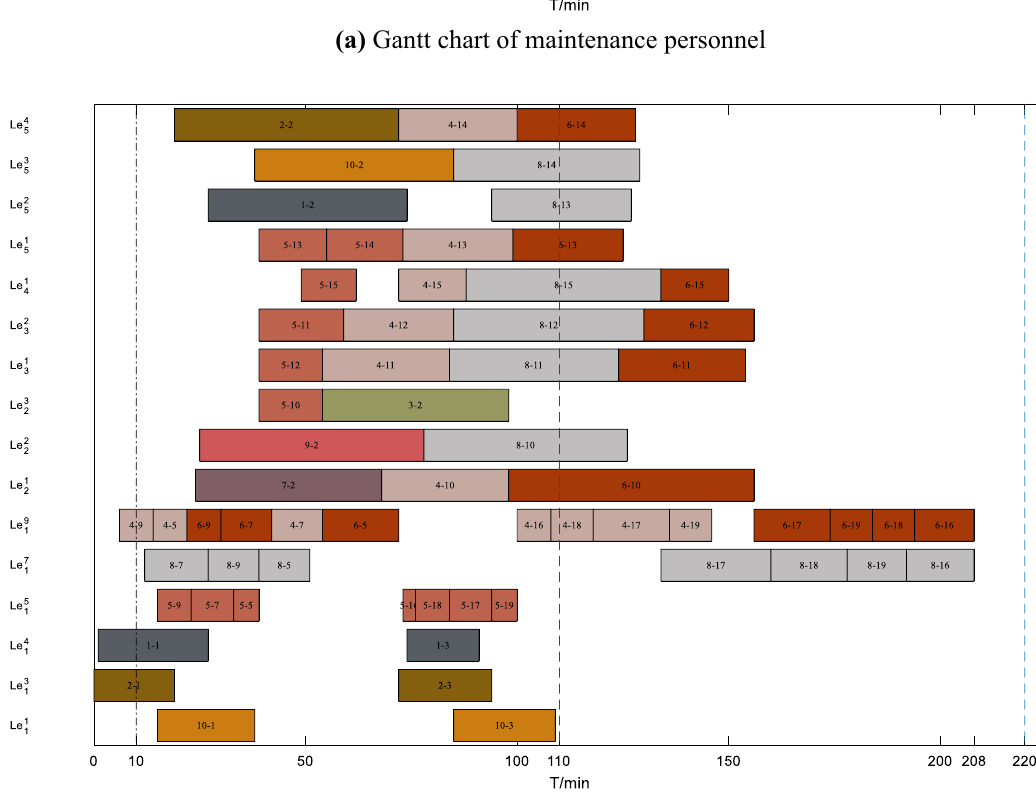
Fig. 23 Complete rescheduling of transferred No.1 maintenance personnel for 10 carrier-based